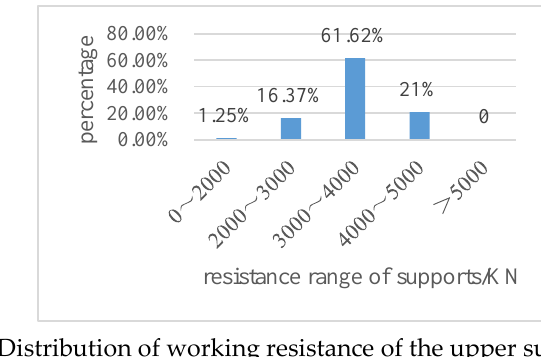
12 of 15 Table 3. Criteria for weighting of hydraulic supports. Measurement Area